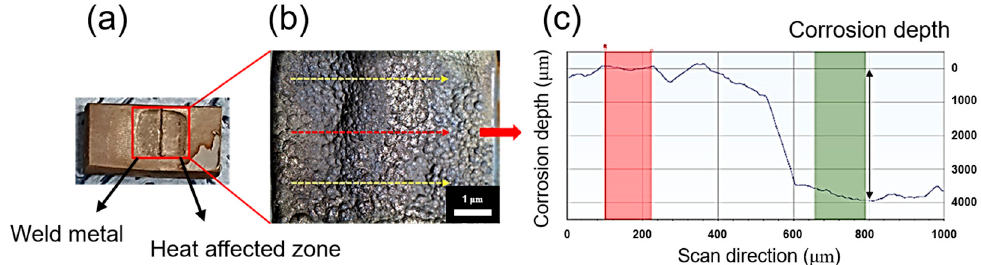
Figure 2. Corrosion depth examination process using a 3D profiler. ( a ) The corroded weldment after the galvanostatic test, ( b ) magnified image of the red square in ( a ), and ( c ) corrosion depth meas- urement.